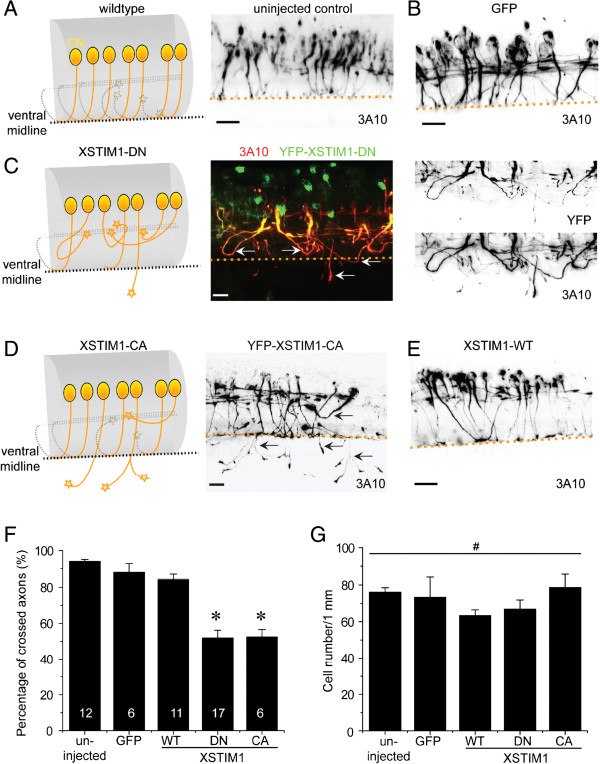
XSTIM1 is required for midline axon guidance of commissural interneurons in the developing Xenopus spinal cord. (A-E) Sample images of the sagittal view of commissural interneurons and their axonal projections in the Xenopus spinal cord from stage 25-26 embryos. Shown are schematic diagrams and confocal z-stack projection images of 3A10 staining of commissural interneuron axons from uninjected embryos, or embryos injected with mRNAs for GFP (B), YFP-XSTIM1-DN (C), YFP-XSTIM1-CA (D), or YFP-XSTIM1-WT (E), at the two to four cell-stage to manipulate a sub-population of neurons. Dotted line represents ventral midline; arrows point to mis-targeted axons. Scale bars: 20 μm. (F) Quantification of the percentage of 3A10+ commissural interneurons with normal midline crossing under different experimental conditions. The number associated with the bar graph indicates the number of embryos examined under each condition. Values represent mean ± s.e.m. (* indicates P < 0.01; Bootstrap-test). (G) Summary of the density of 3A10+ commissural neurons under each condition. The same embryos as in (F) were examined. Values represent mean ± s.e.m. (# indicates P > 0.1; Bootstrap-test).